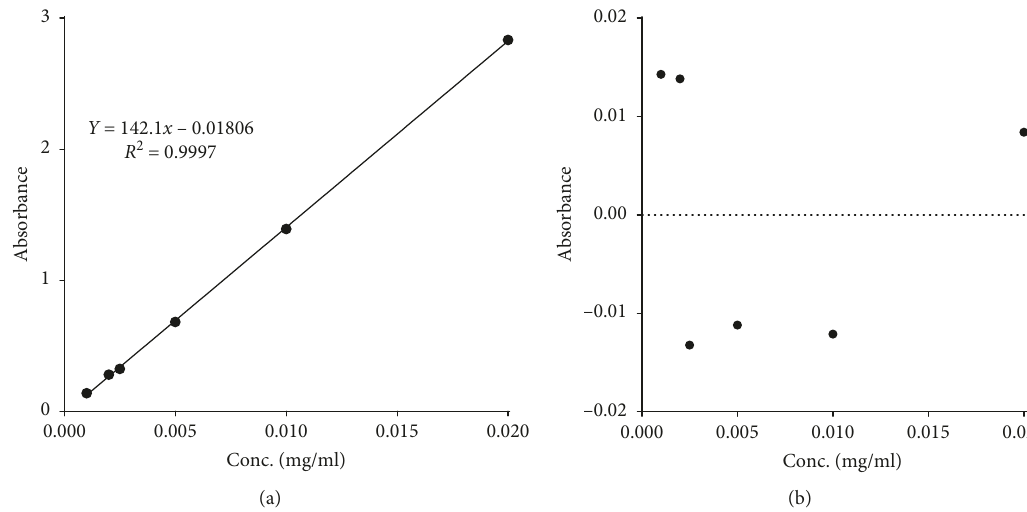
Figure 3: Proof of linearity and its corresponding concentration range for achieving the linearity. (a) Linearity plot involving the concentrations used (abscissa) and their corresponding mean absorbances ± SEM (ordinate). (b) Residual plot showing the randomicity of the plotted figures, which further proves linearity.